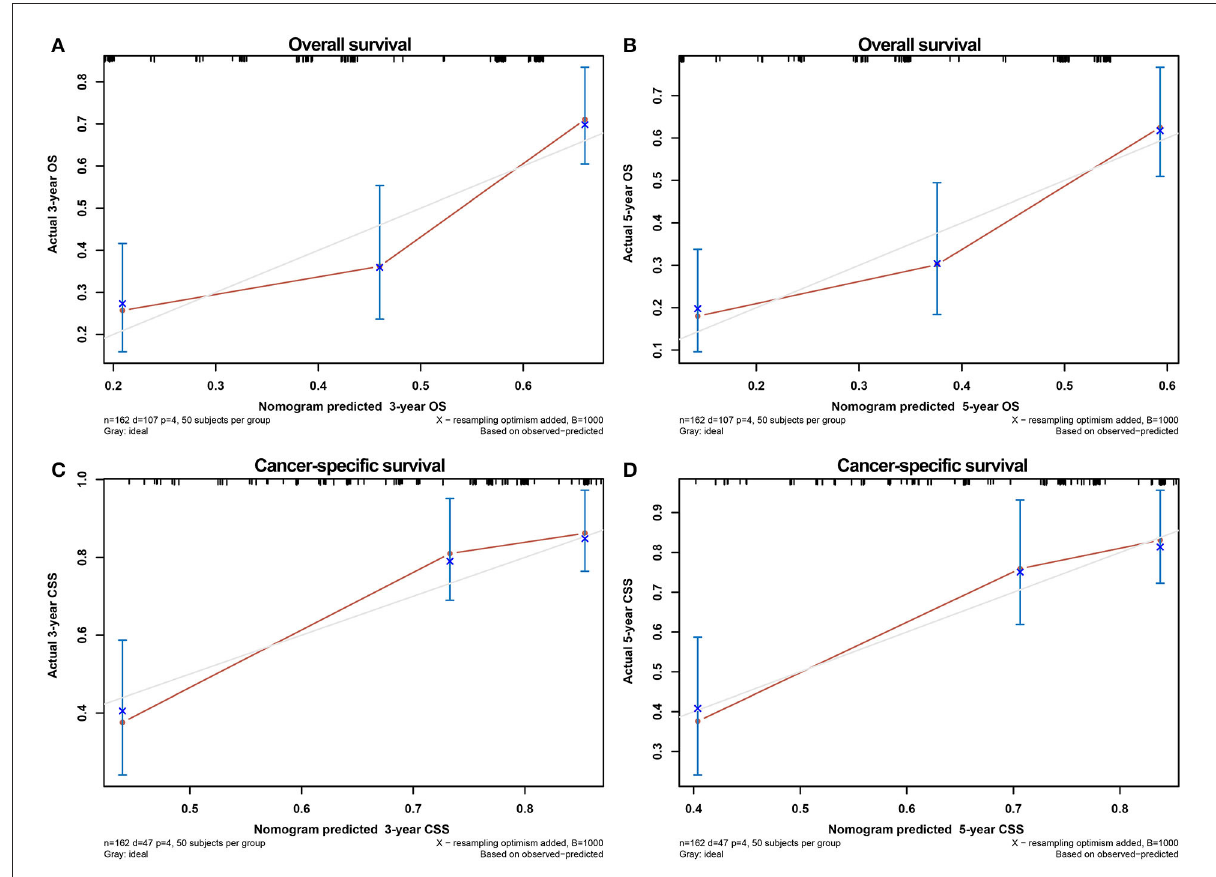
FIGURE5 Calibration curves for verifying the consistency between predicted 3-,5- OS and CSS and actual 3-,5- OS and CSS in the training cohort. 3- OS (A) and 5- OS (B) calibration curves; 3- CSS (C) and 5- CSS (D) calibration